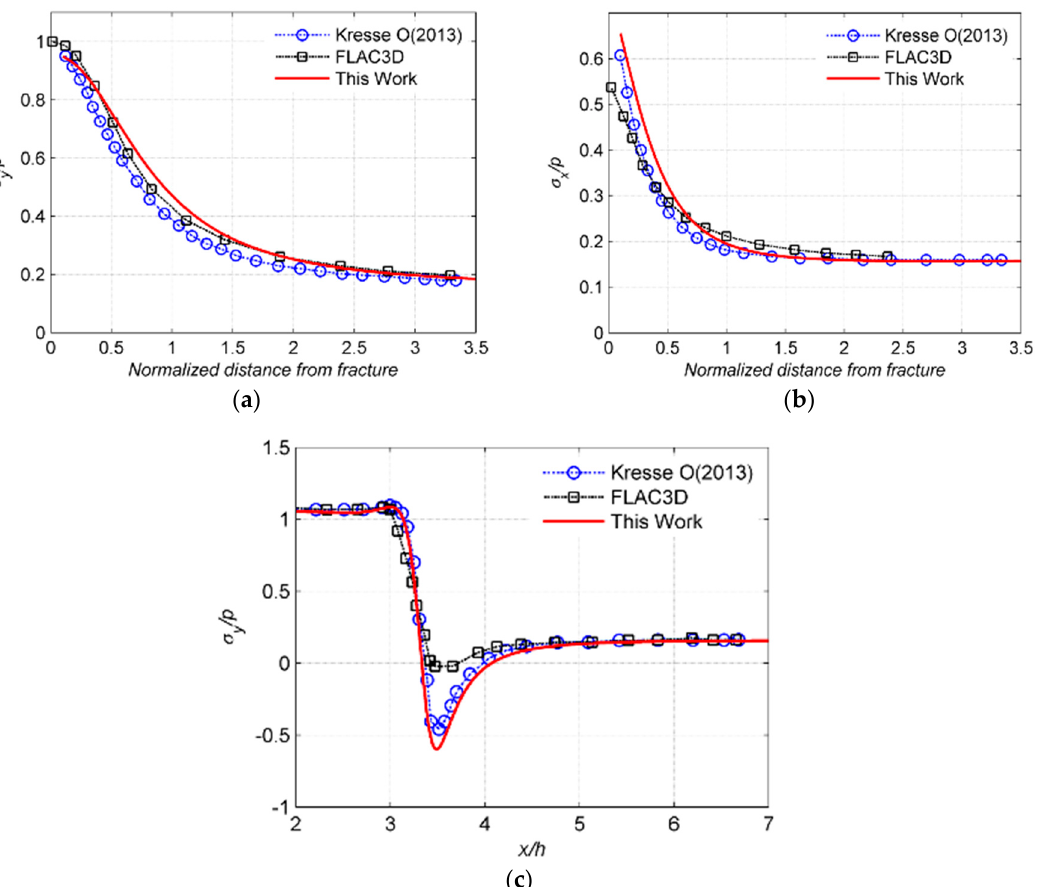
Figure 3. Comparison of the model with FLAC3D and the numerical model of Kresse, Weng, Gu and Wu [30]. ( a ) σ y along the y -axis; ( b ) σ x along the y -axis; ( c ) σ y along the x